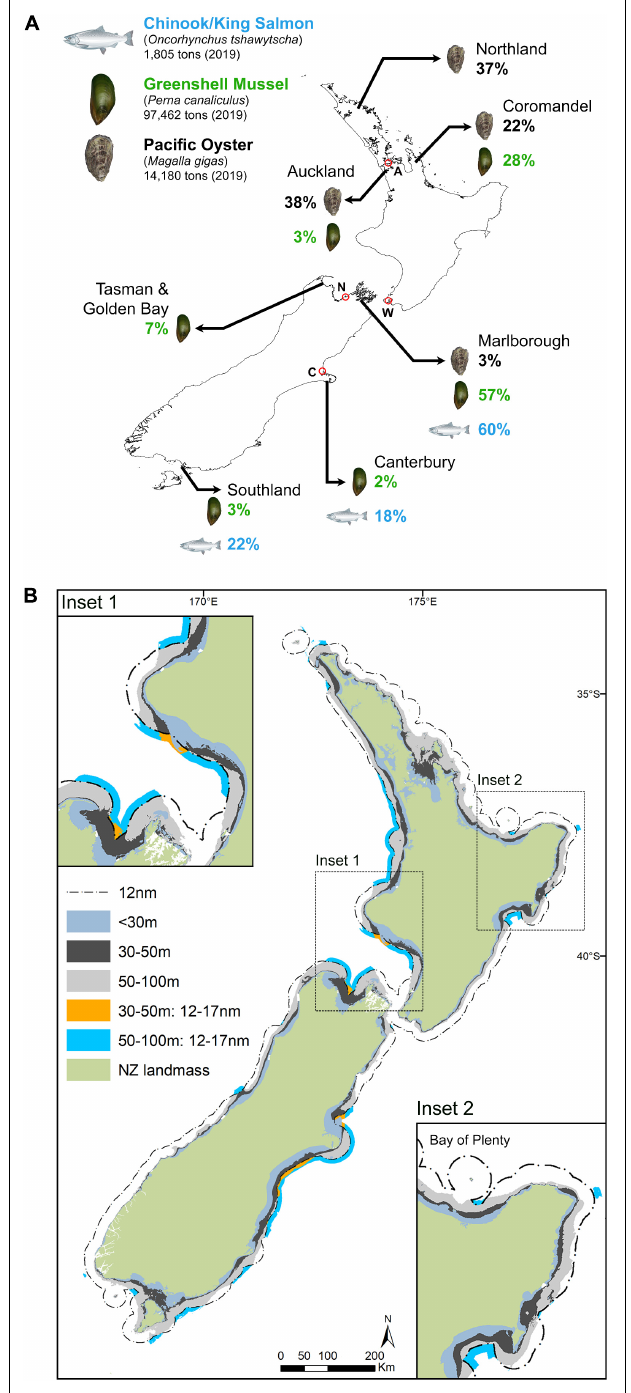
FIGURE 1 | Map of the bathymetry and potential area for aquaculture in New Zealand: (A) shows the culture regions of the three primary marine aquaculture species found in New Zealand displayed either in total production tons · species − 1 and species in% · area − 1 ; (B) shows the different available areas for aquaculture divided into isobaths: 30–50 m and 50–100 m within the territorial sea as well as 30–50 m and 50–100 m within the 12 to 17 nautical mile zone beyond the territorial sea. (Salmon and mussel images from Illustration©2020, Eden Cartwright, Bird Circus).